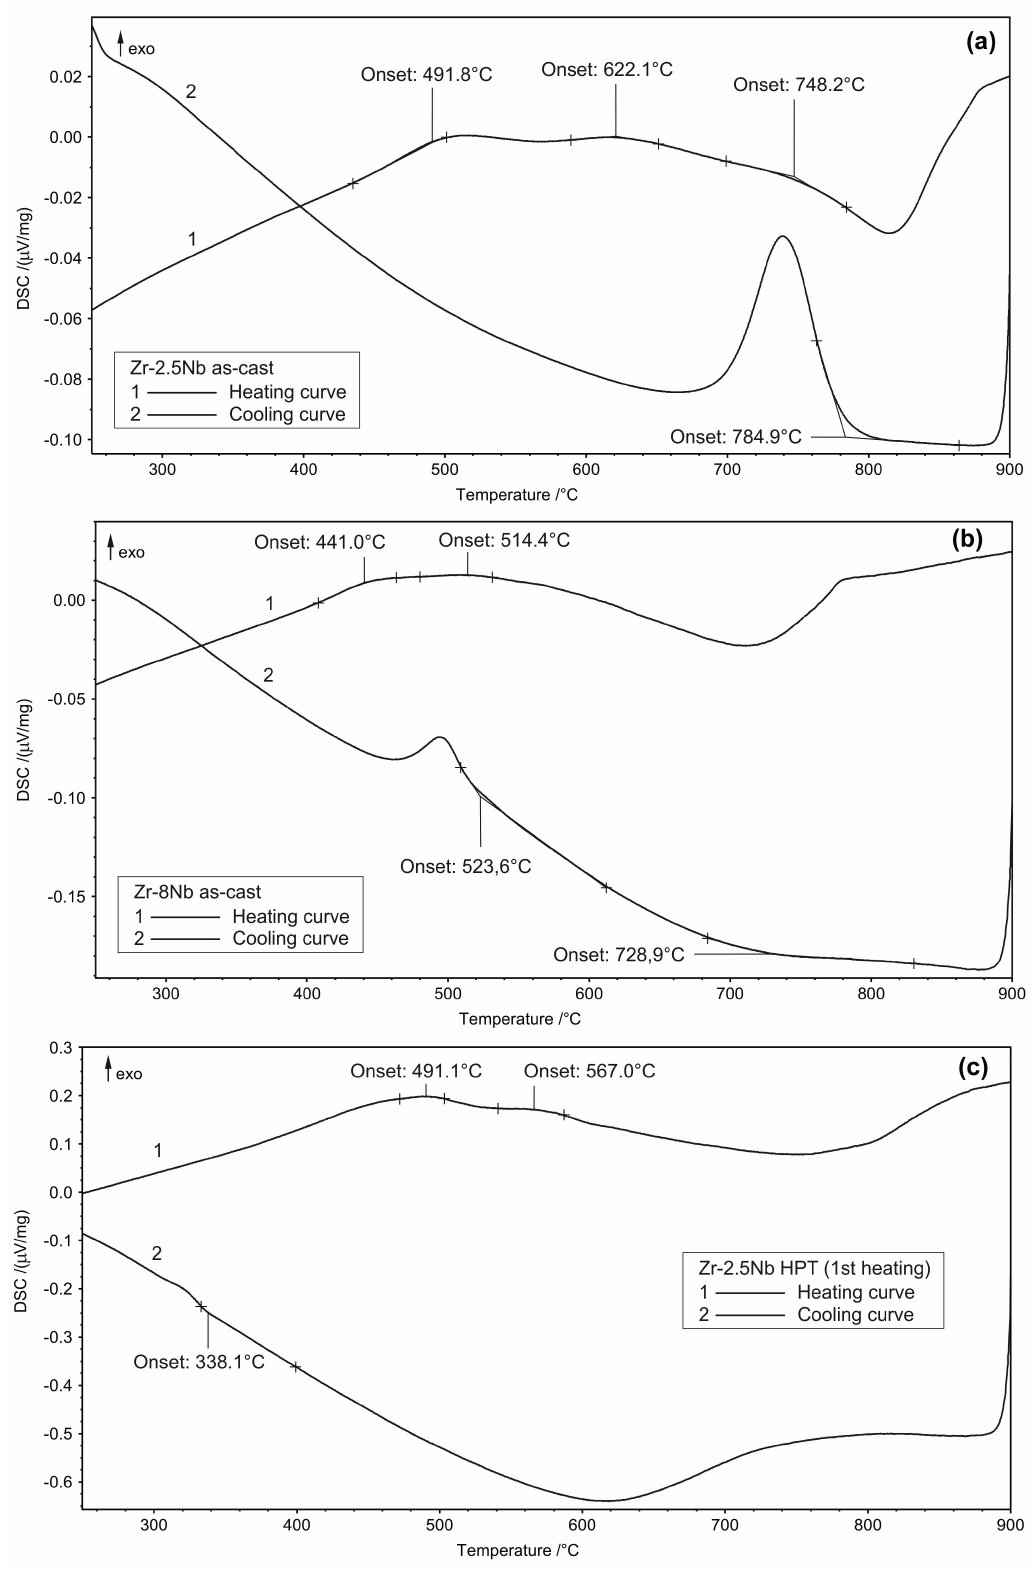
Figure 4. The temperature dependences of heat flow DSC by heating (upper curves) and by cooling (lower curves) for (a) as-cast CG Zr-2.5 mass% Nb alloy, (b) as-cast CG Zr-8 mass% Nb alloy and (c) UFG Zr-2.5 mass % Nb alloy after HPT (first